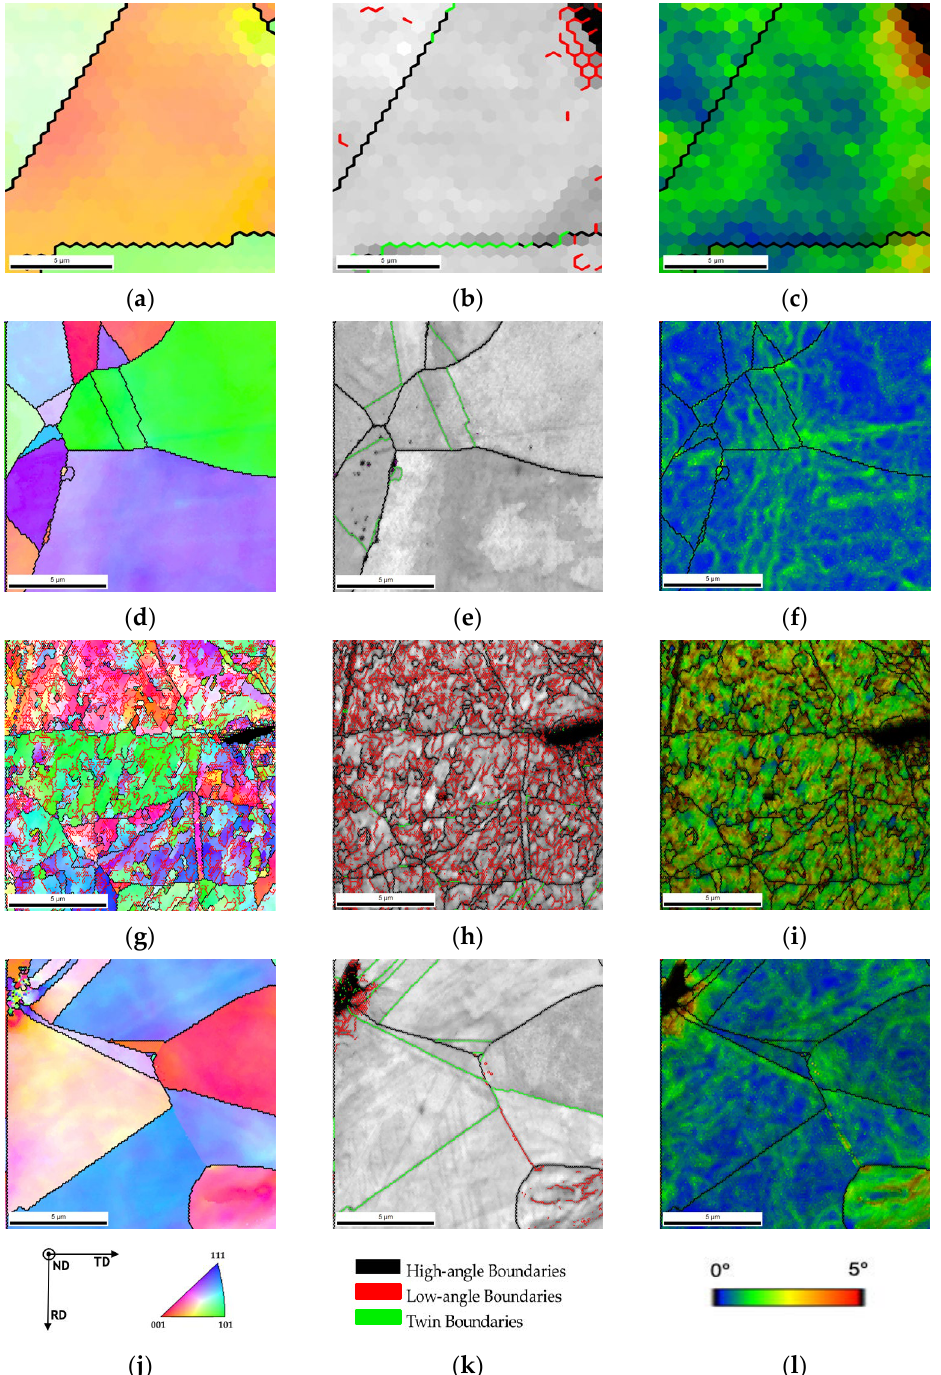
Figure 8. IPF, IQ with high- and low-angle boundaries and twin boundaries delineated, and Kernel average misorientation (KAM) maps of ( a – c ) Ni heat-treated at 700 °C for 120 min ( d – f ) Ni heat-treated at 1100 °C for 30 min, ( g – i ) Ni-1.00 vol.% CNT heat-treated at 700 °C for 120 min and ( j – l ) Ni-1.00 vol.% CNT heat-treated at 1100 °C for 30 min.